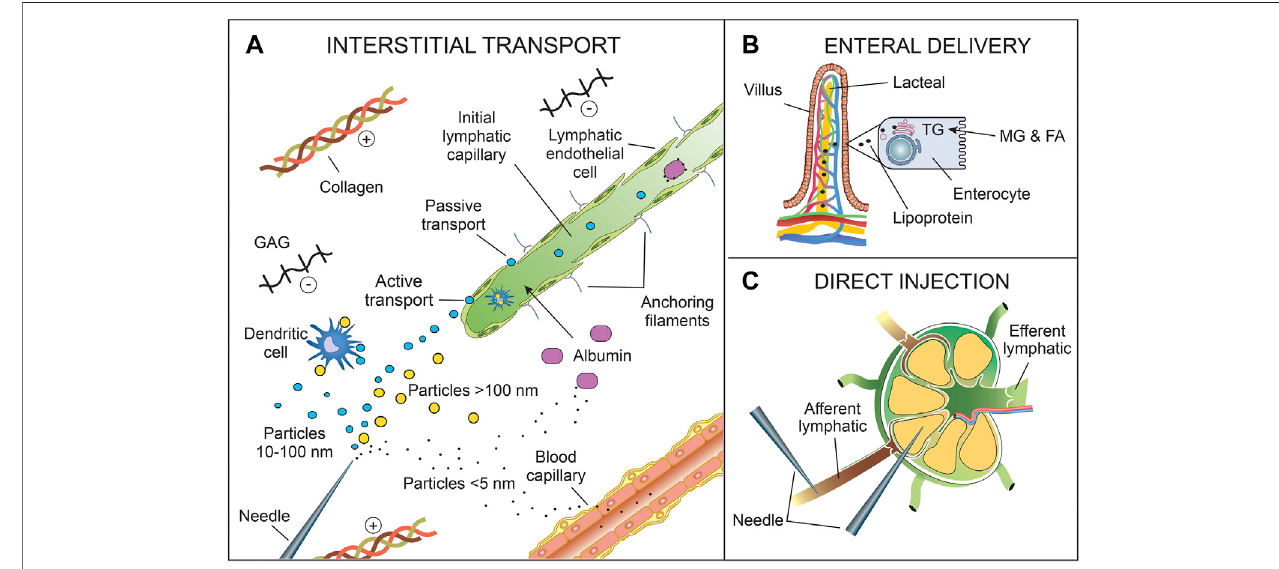
FIGURE 2 | Delivery routes for lymphatic uptake of fl uorescent tracers. (A) Interstitial transport includes intradermal, subcutaneous, submucosal, peritumoral, or intraparenchymal injection. Other delivery routes (enteral, endotracheal, intra-articular, intravascular) also include interstitial transport prior to lymphatic uptake. The tracersenterlymphatic vessels eithersinglyor bound tointerstitial cells (e.g., dendritic cells) or macromolecules (e.g., albumin) via passivetransport between endothelial cells or active transport acrossendothelialcells. Particles > 10 nm (or > 20 kDa) (blue) are generallytaken upby the lymphatics, as opposed tothe blood capillaries. Particles > 100 nm (or > 30 kDa) (yellow) are still taken up by lymphatics but diffuse poorly through the interstitium. Particles < 5 nm (or < 20 kDa) (black dot) preferentially enter blood capillaries if they remain unbound. (B) Enteral delivery of fl uorescent tracers to mesentericlymphatics can be achieved byusing aFA fl uorescent tracer (e.g., BODIPY) or conjugating the tracer to a FA. Dietary triglycerides are broken down into FAs and 2-MG by pancreatic lipase prior to absorption. Similarly, lipophilic fl uorescent tracersneedtobesmallFAsorstableinthegastrointestinaltracttoprevententericbreakdown.Onceabsorbed,FAs( > 10carbonatomsinlength), including fl uorescent FAs, are reesteri fi ed into TGs and then incorporated into lipoproteins within the enterocytes. Lipoproteins, primarily chylomicrons, are preferentially taken up in the lacteal. (C) Fluorescent tracers can be injected directly into lymphatic vessels or nodes. Although not shown here, the tracer may enter the LN through intra-nodal high endothelial venules after intravenous injection. Also not shown is intraperitoneal delivery. Abbreviations: FA, fatty acid; GAGs, glycosaminoglycans; MG, 2- monoglyceride; TG, triglyceride.